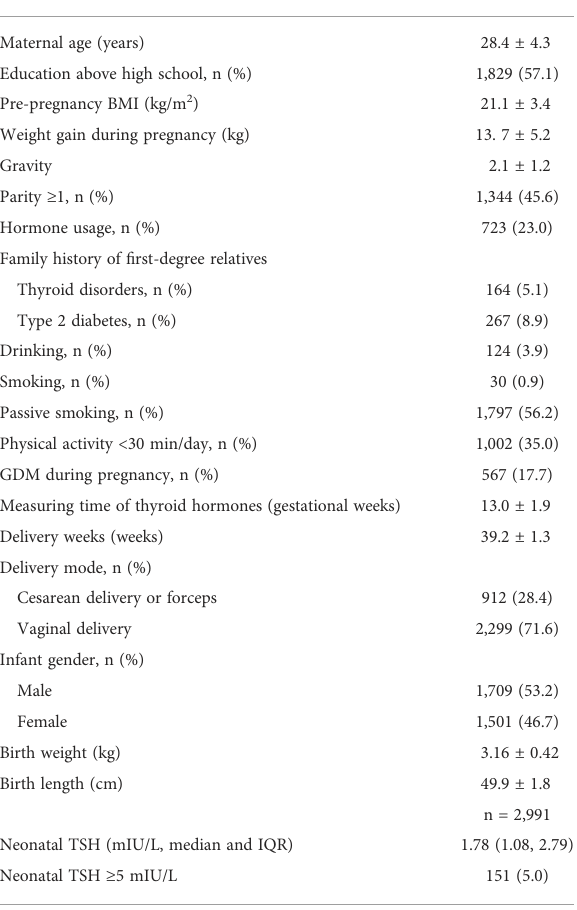
TABLE 1 Basic characteristics and birth outcomes of pregnant women, Huizhou mother-infant cohort 2018 – 2020 (n = 3,210). Participants